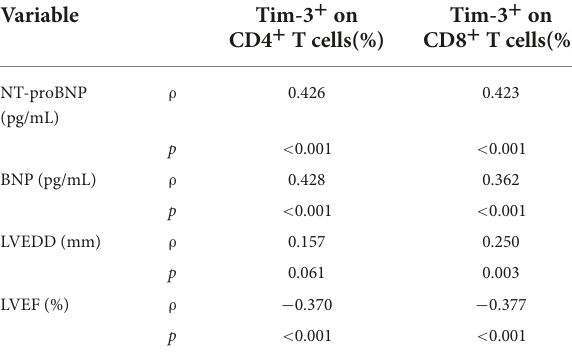
TABLE 2 Correlation between Tim-3 expression and different heart failure